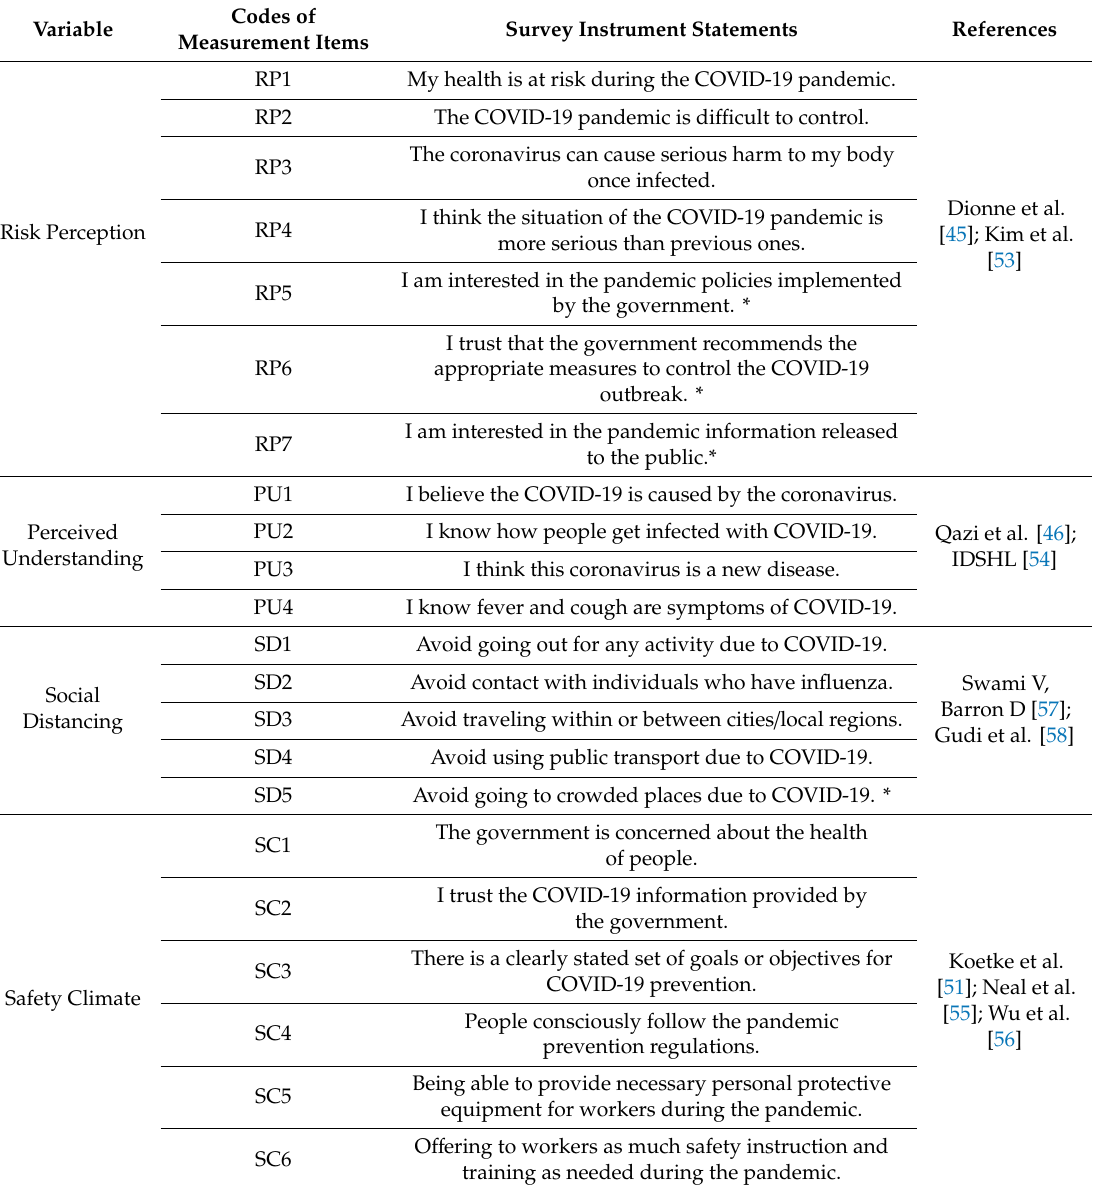
Table 2. Overview of questionnaire